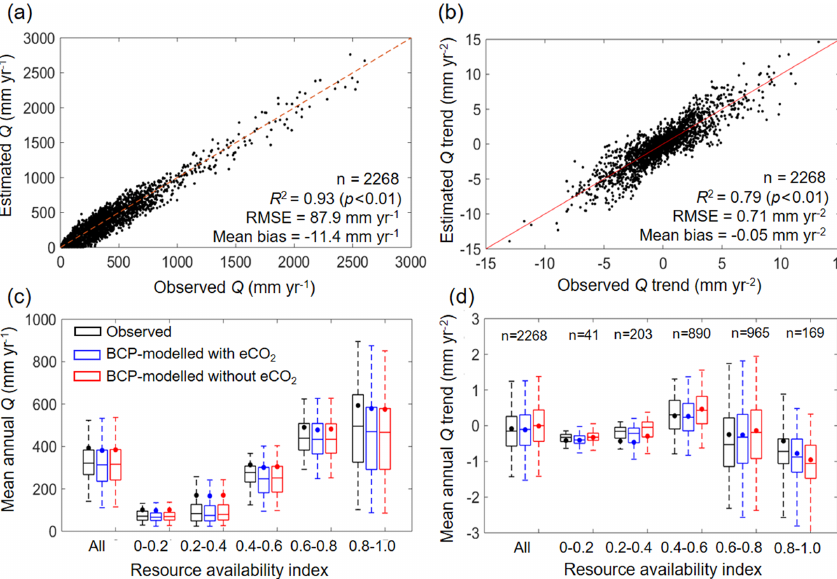
Figure 4. Validation of estimated Q at catchments. (a) Model performance in predicting mean annual Q in 2268 catchments over 1982–2010. (b) Model performance in predicting Q trend in 2268 catchments during 1982–2010. (c) Model performance in predicting mean annual Q in 2268 catchments over 1982–2010 stratified by resource availability index category. (d) Model performance in predicting Q trend in 2268 catchments over 1982–2010 stratified by resource availability index category. The number of catchments in each resource availability index category are provided at the top of each subplot. The legend from (c) applies to (d) . In (c) and (d) , the upper and lower box edges represent the quartile division, the inner horizontal line is the median, the dots indicate the mean, and the dashed lines represent the 5th and 95th